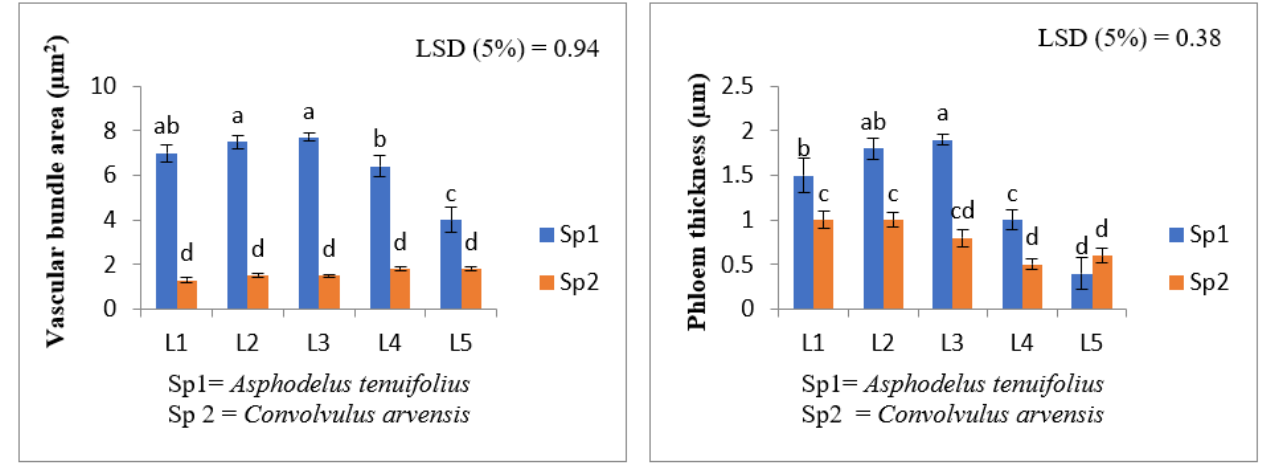
Figure 1. Effect of shoot extract of T. portulacastrum and herbicide on root anatomical parameters of A. tenuifolius and C. arvensis. L1 = distilled water; L2 = 30%; L3 = 60%; L4 = 100% and L5 = herbicide treatment. Means followed by the same letter did not significantly differ at p ≤ 0.05 according to LSD test.